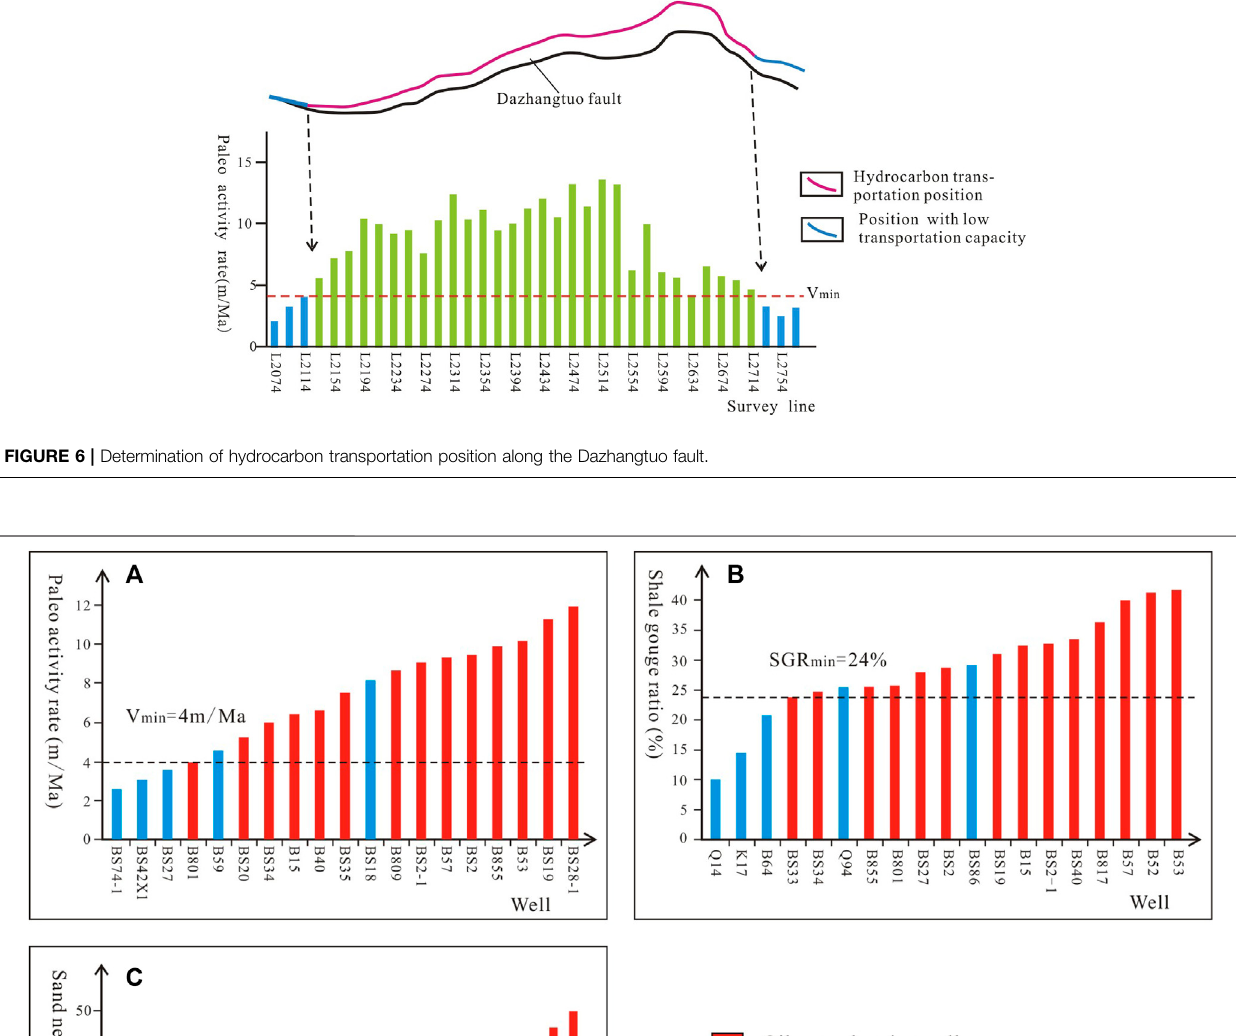
shale content of the layer disrupted by the fault were calculated